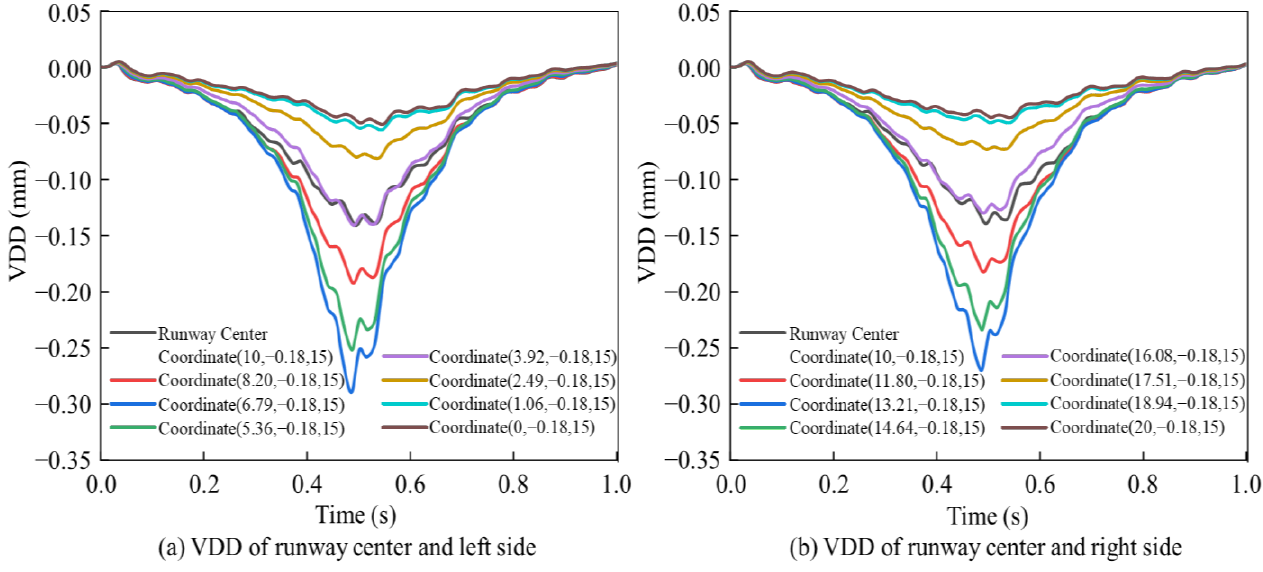
Figure 9. Multipoint dynamic displacement of surface dynamic displacement acquisition path in the time domain.